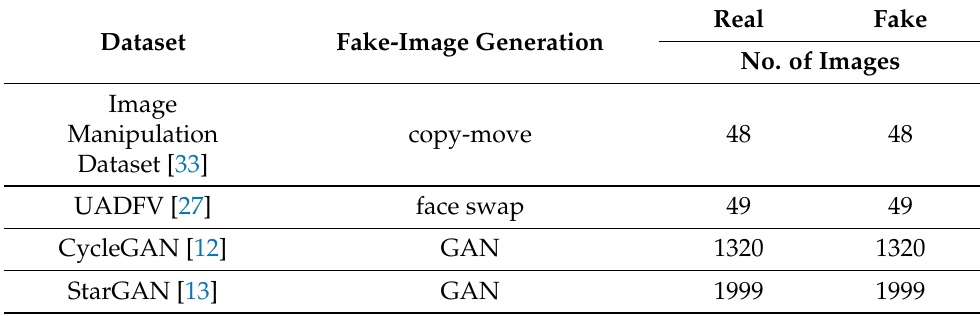
Table 1. Datasets used in the